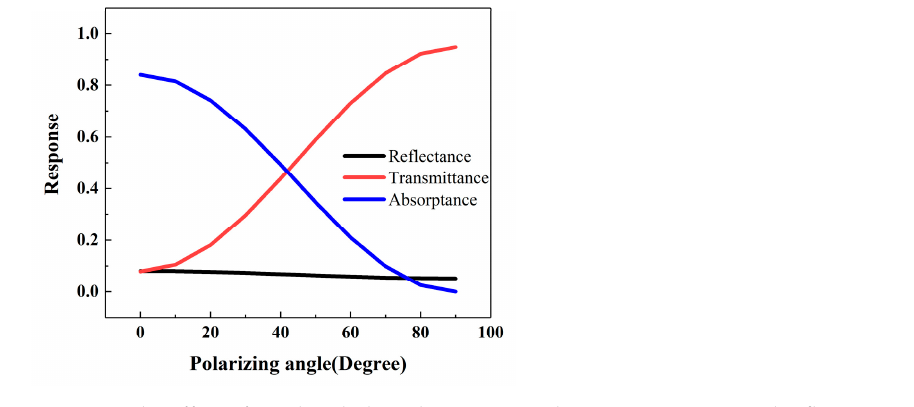
Figure 7. The effect of incident light polarization angle on transmission and reflection ratios. 2.2. Polarization-Dependent Transmission and Absorption Structure for Circularly Polarized Light